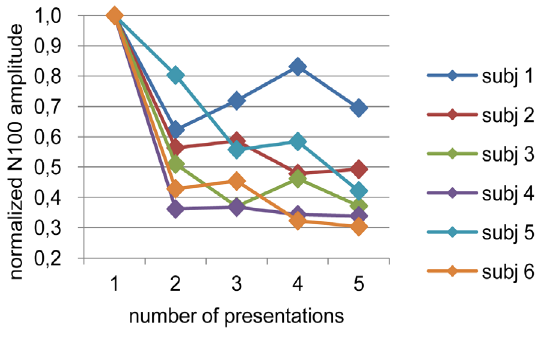
Figure 5. Habituation of the N100m source. The amplitudes are normalized to the responses to the first stimulus.